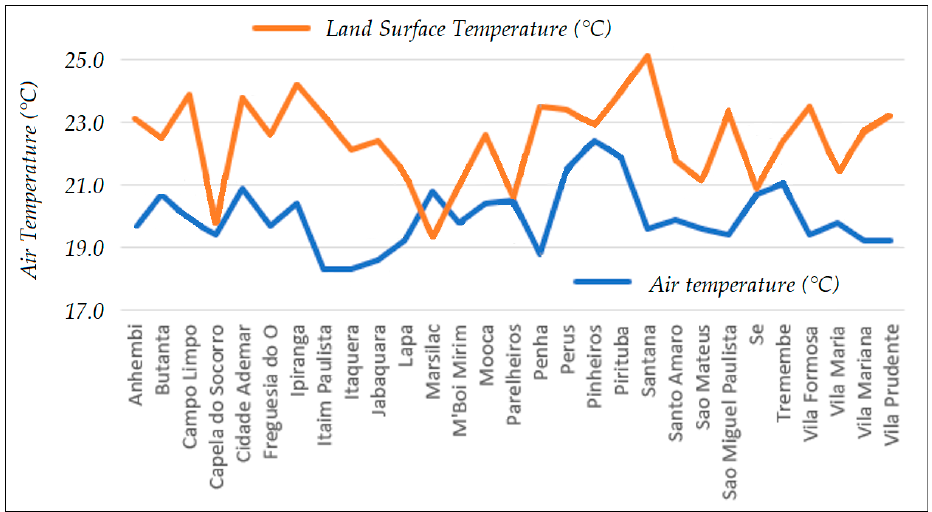
Figure 5. Graph of air temperature and land surface temperature at each CGE’s weather station in São Paulo City on 17 August 2019 in the autumn–winter season. Source: Management Centre of Climate Emergencies of the São Paulo City, 2019.